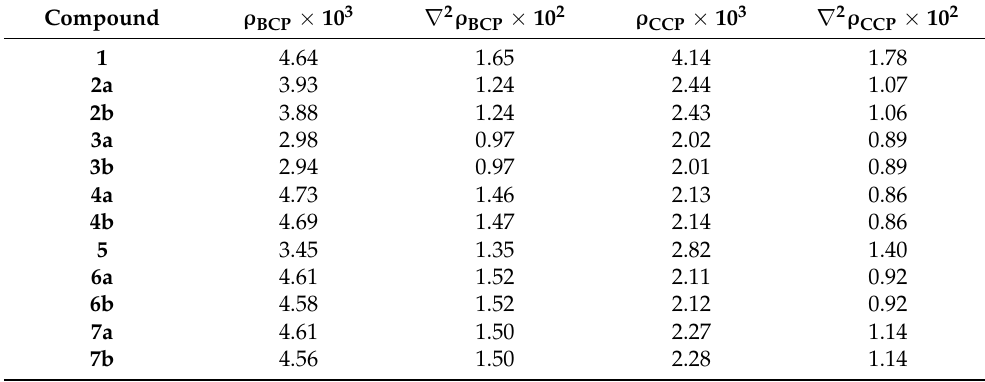
Figure 5. Molecular graphs of a selection of two-component complexes ( 1 , 2a , 2b , 4a , 4b , 7a ). The BCPs, ring and cage critical points are represented by green, red, and blue dots, respectively. Only bond paths are depicted (intermolecular bond paths are shown as dashed lines). Carbon, nitrogen, oxygen, and hydrogen atoms are indicated in grey, blue, red, and white color, respectively. Table 4. Electron density ( ρ BCP and ρ CCP ) and Laplacian ( ∇ 2 ρ BCP and ∇ 2 ρ CCP ), in a.u., for the intermolecular bond critical points and cage critical points, respectively, in two-component complexes.